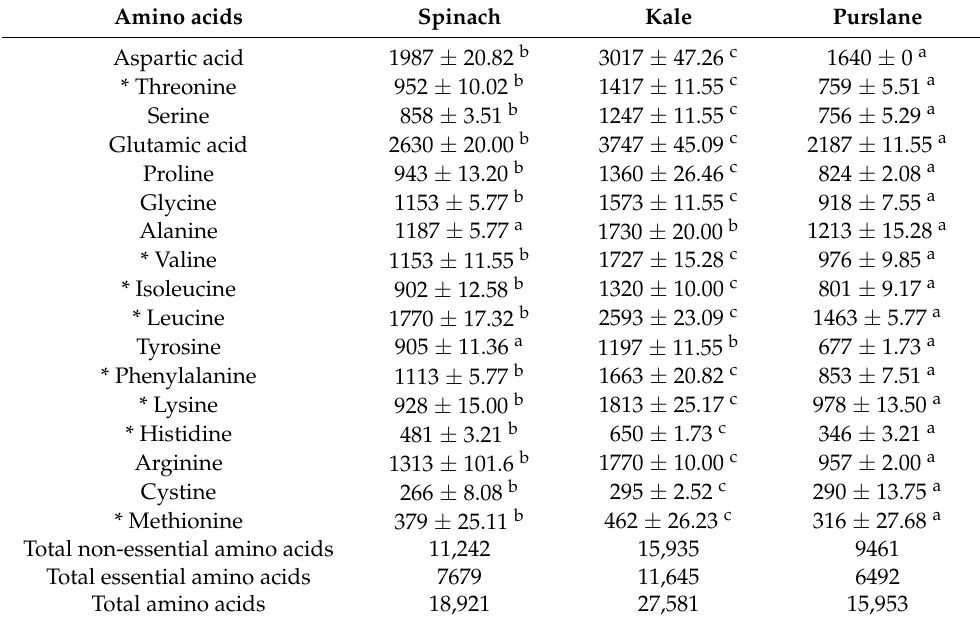
Table 3. Amino acid content in spinach, kale, and purslane [10] (Mean mg/100 g ± SD; n = 3), dry